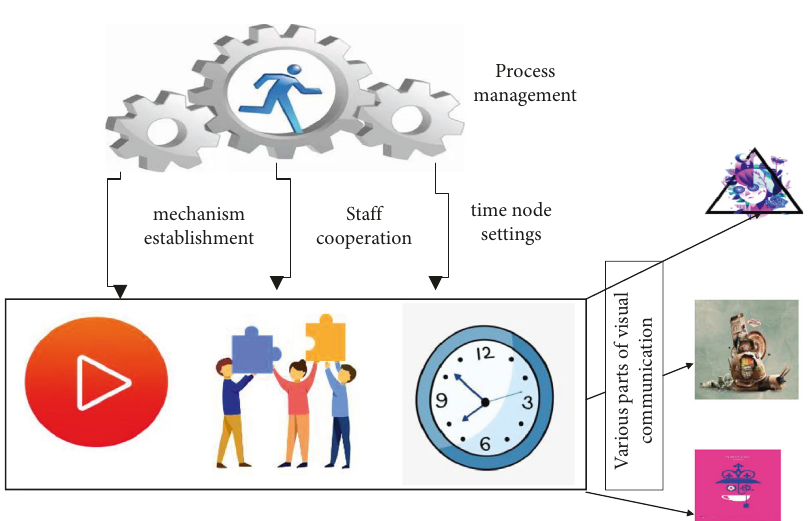
Figure 2: Logical structure diagram of the process control